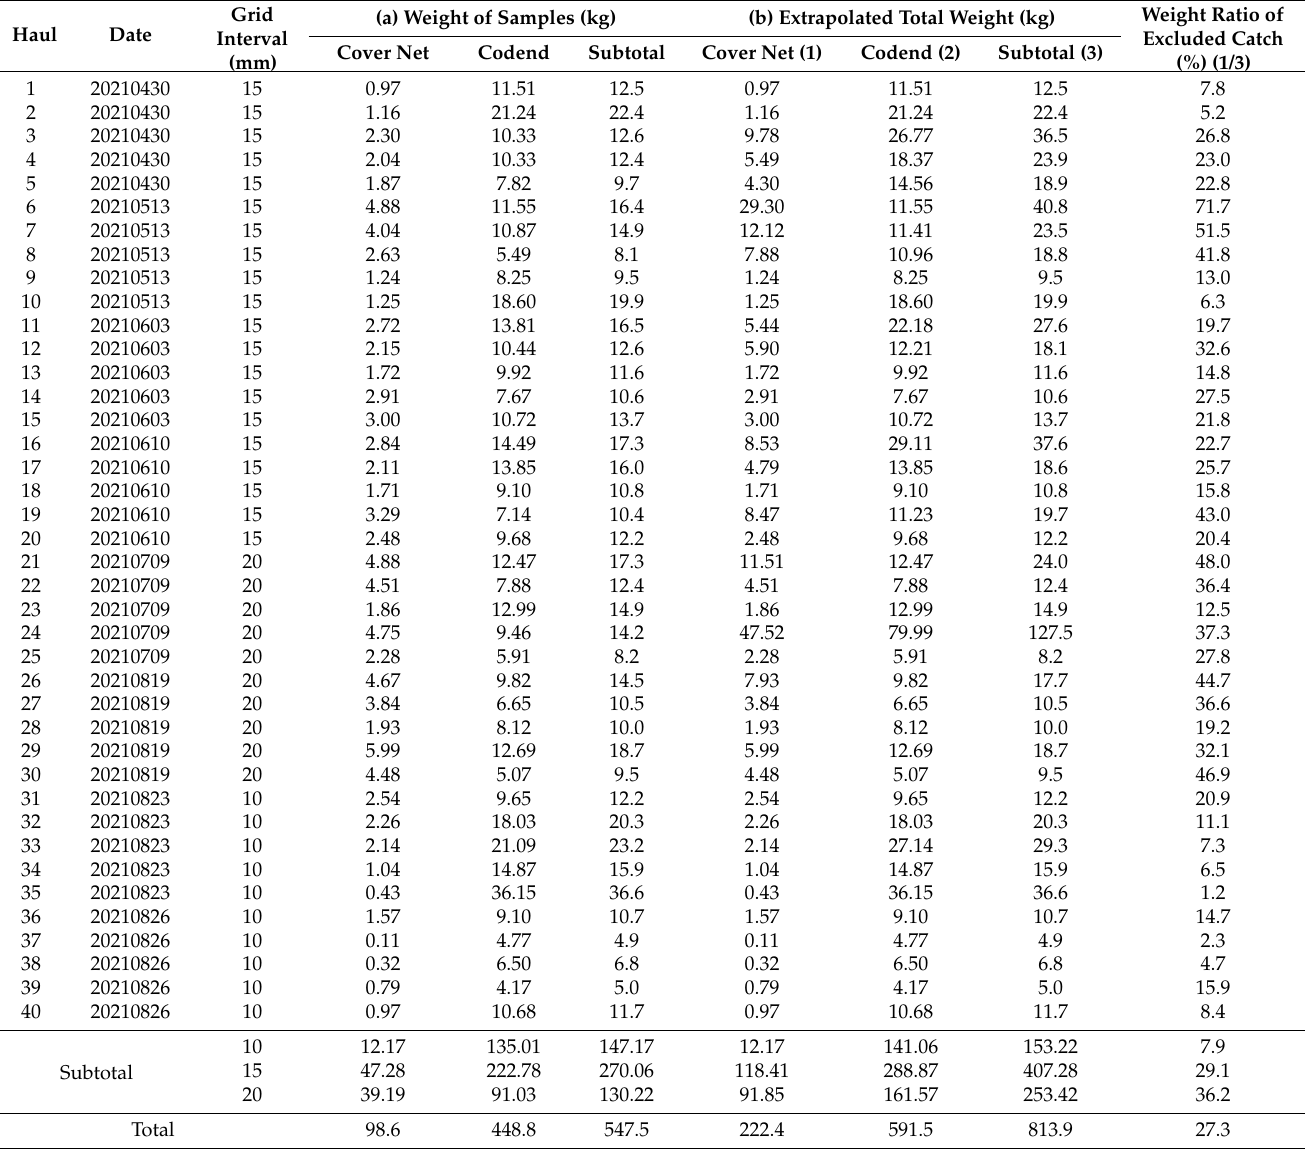
Table 1. Weight of catches in tests of proposed